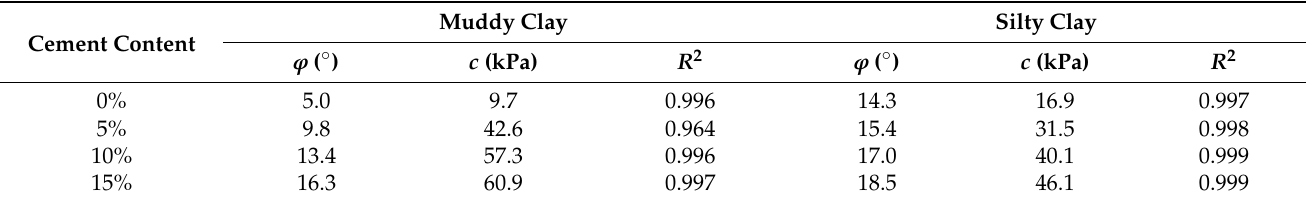
Table 5. Shear strength parameters of soil around piles with permeation